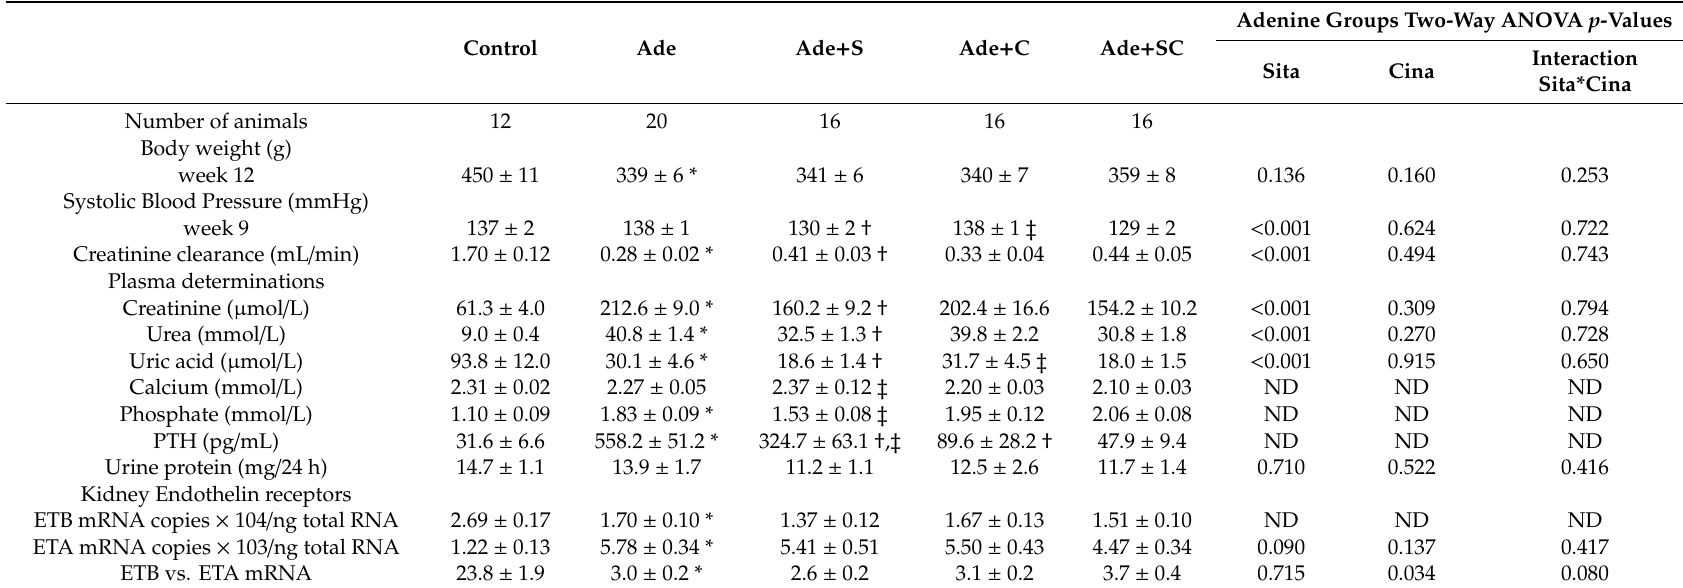
Table 3. Animal data and laboratory findings at the end of the twelve-week adenine